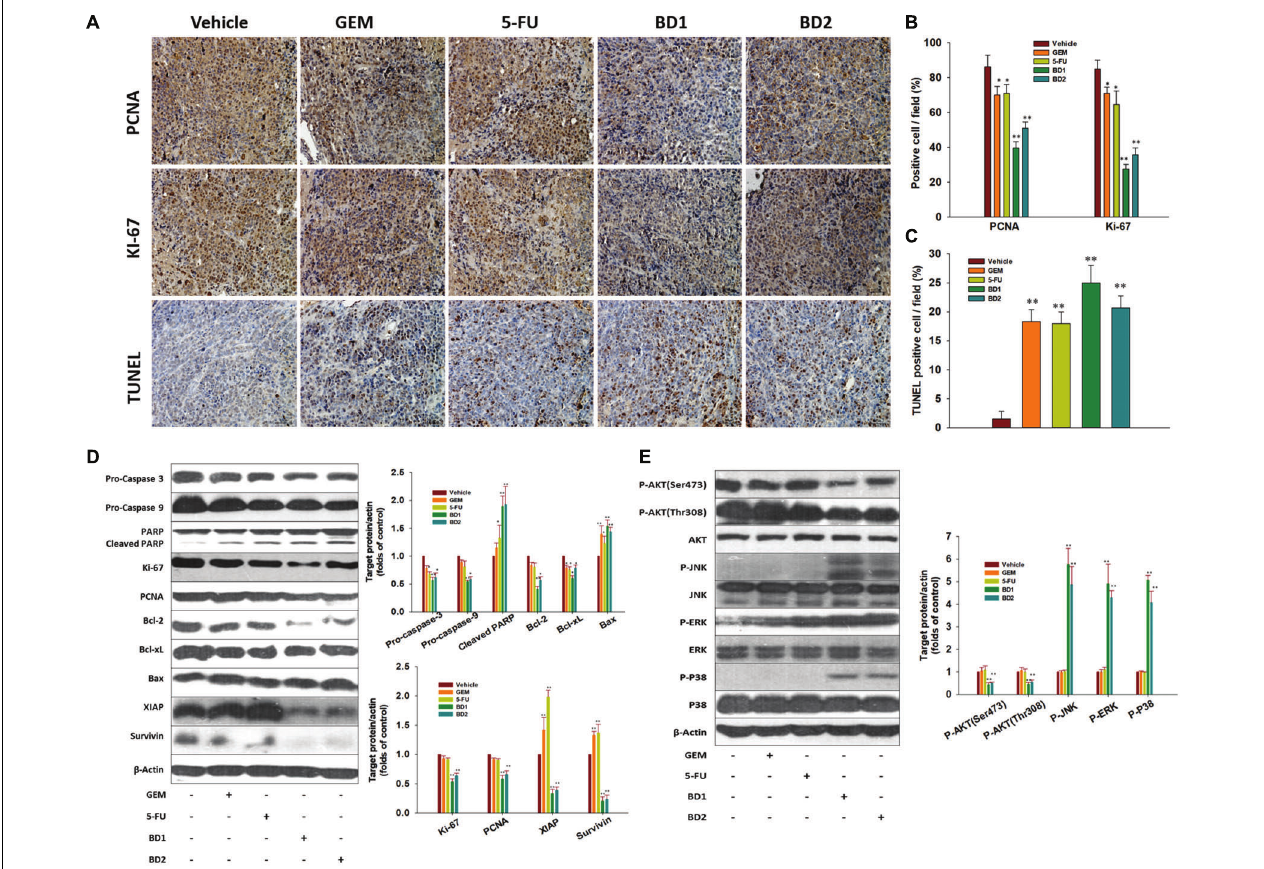
FIGURE 7 | BD inhibits the proliferative index and elicits apoptosis in orthotopic xenograft mouse model. (A–C) The representative tumor tissue sections from xenografts in different treatment groups were analyzed by immunohistochemical analysis for the protein expression of the proliferation markers PCNA and Ki-67. The apoptotic cells were stained by TUNEL agent. Scale bar, 20 µ m (A) . Quantification of PCNA/Ki-67/TUNEL positive cells (B,C) . A total of 10 fields (40 × ) were examined and stained cells were determined in four tumor tissues from each group. Each column represents the mean ± SD of four samples. ∗ P < 0.05 and ∗∗ P < 0.01 vs. the control group. (D) Western blotting analysis showed the expression of procaspase-3, procaspase-9, PARP, Ki-67, PCNA, Bcl-2, Bcl-xL, Bax, Survivin, and XIAP detected in different treatment groups. β -Actin served as the protein loading control. (E) Western blotting analysis on the expression of PI3K/Akt and MAPK pathways-related proteins from respective tumoral homogenate, with β -actin serving as the protein loading control. Data are shown as the mean ± SD from three independent experiments, ∗ P < 0.05 and ∗∗ P < 0.01 vs. the control